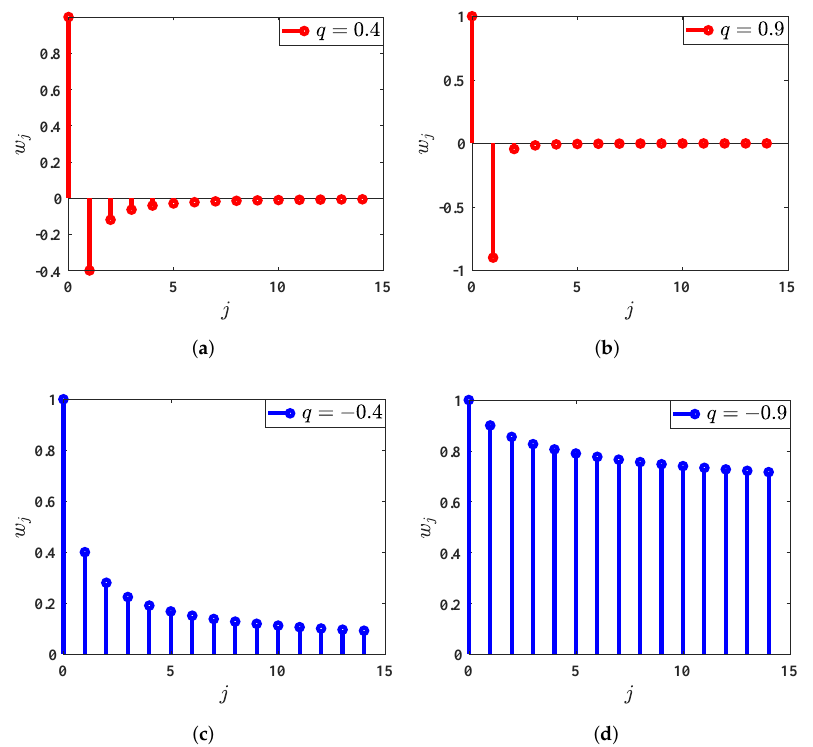
Figure 1. Binomial coefficients against fixed-window iterations at ( a ) q = 0.4, ( b ) q = 0.9, ( c ) q = − 0.4, and ( d ) q = − 0.9.